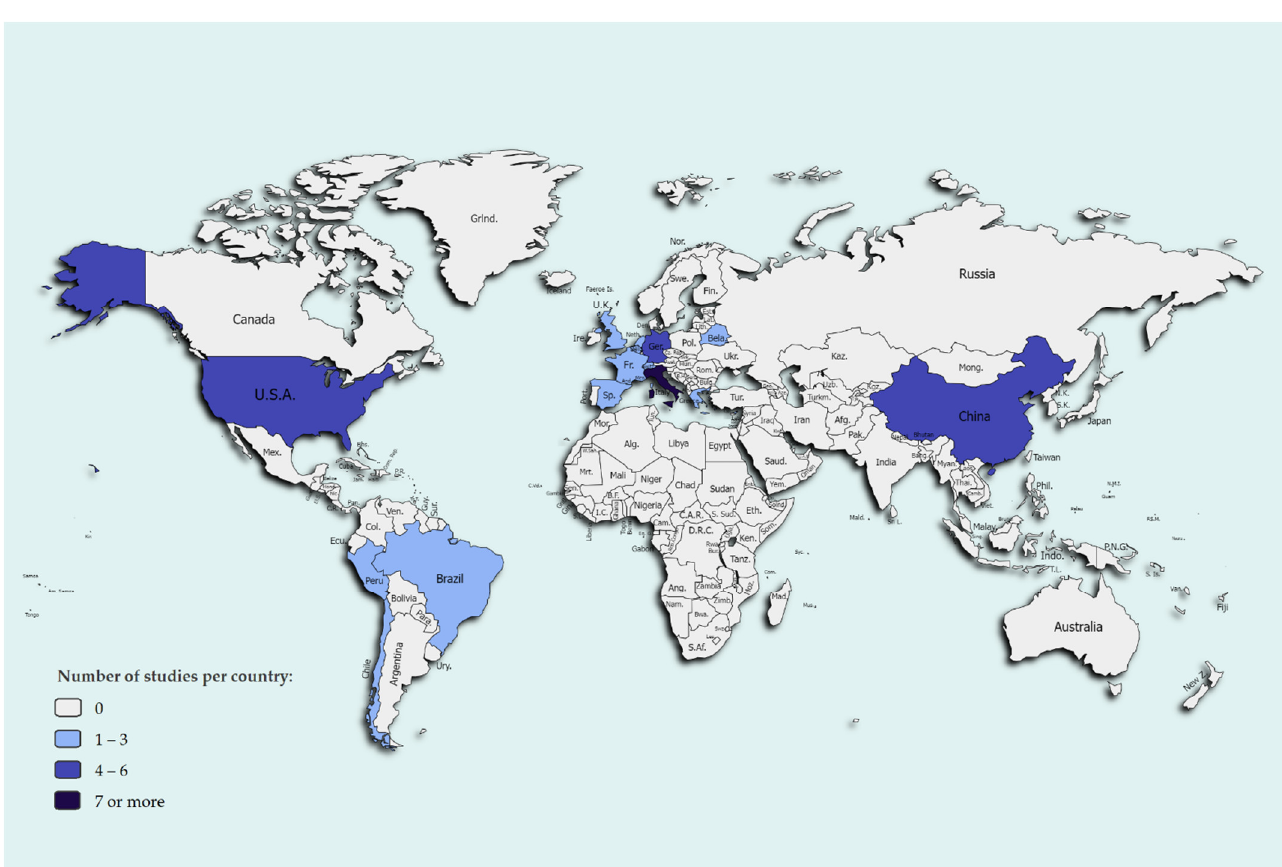
Figure 2. Number of studies included in the review per country. With seven studies, the highest number of studies was performed in Italy. In both China and Germany, there were five studies, while in the USA, four studies were conducted. In all other countries (Belarus, Belgium, Brazil, Chile, Greece, Netherlands, Northern Cyprus, Peru, Spain, Switzerland, and the United Kingdom) either one or two studies were performed. Table 2. Overview of eligible records and their aims.